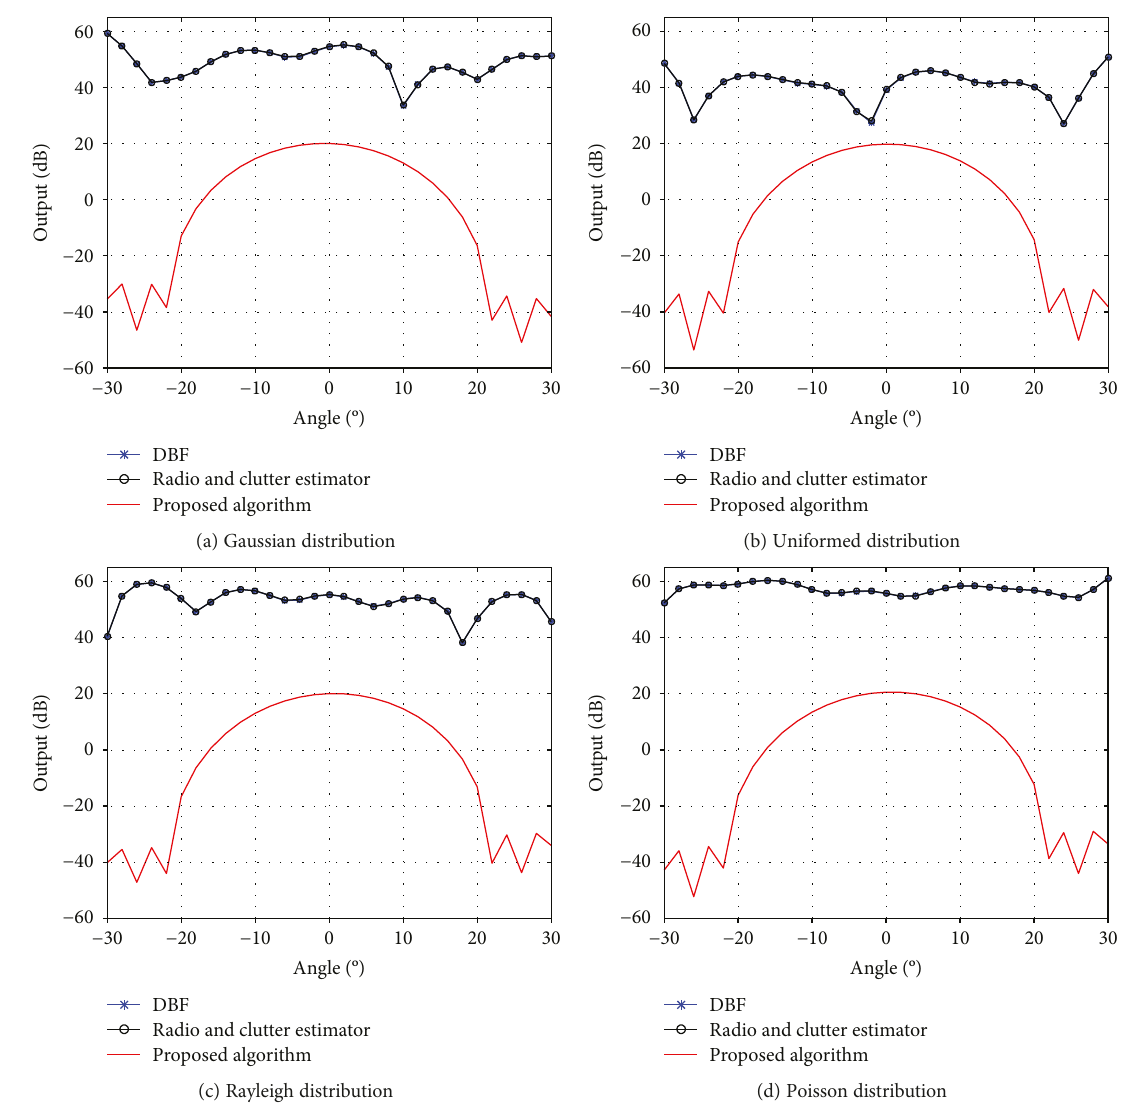
Figure 7: Simulations for radio and clutter submitted to four distributions.